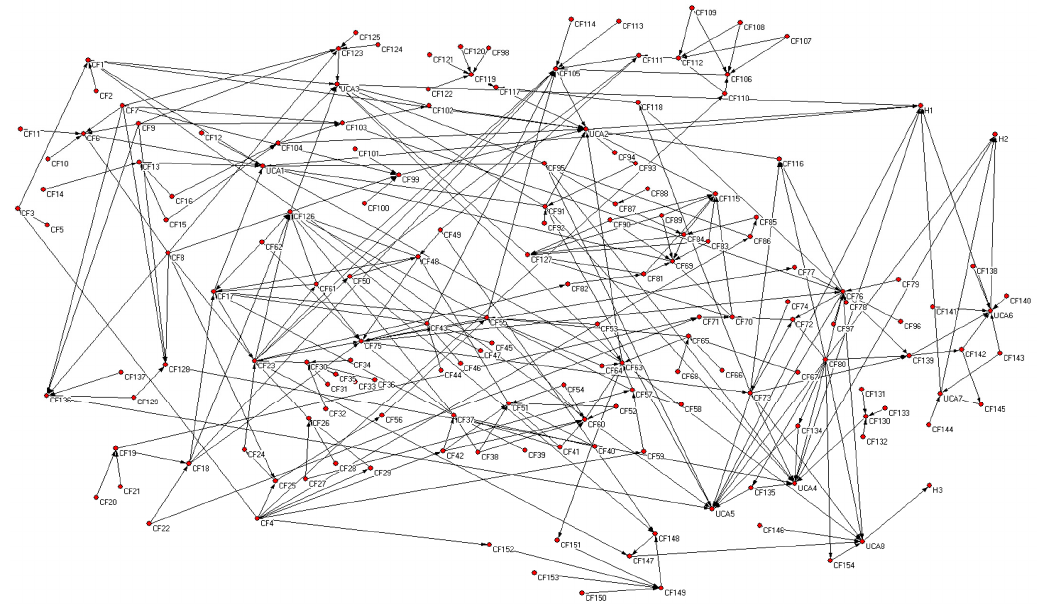
Figure 5. The hazardous factors network of the human–IRDAS driving system. By Equation (6) and Equation (7), the active correlations and passive correlations of hazardous factors are evaluated, as is shown in Figure 6. Some causal factors at the left side of the dotted line in the figure have large passive correlation values and small active correlation values, for example, “the working condition of the train affects the quality of the image from cameras” (CF26), “water film or sand covers the lens” (CF29), and “some